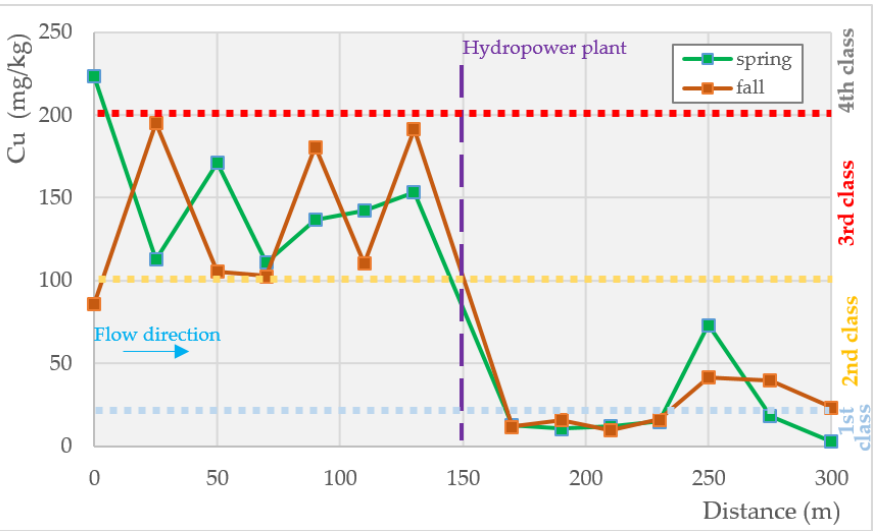
Figure 5. Changes in copper concentrations in sediments in spring and fall near the hydropower plant on the Ślęza River, along with the geochemical classification.